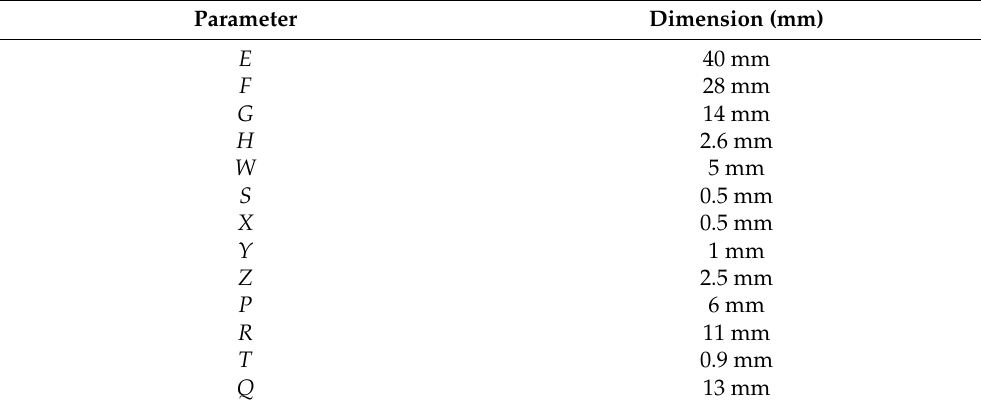
Figure 1. Proposed triple band UWB antenna with dual notch ( a ) Top-layer ( b ) SSRR Unit-cell ( c ) Bottom-layer. Table 1. Proposed antenna dimensions.